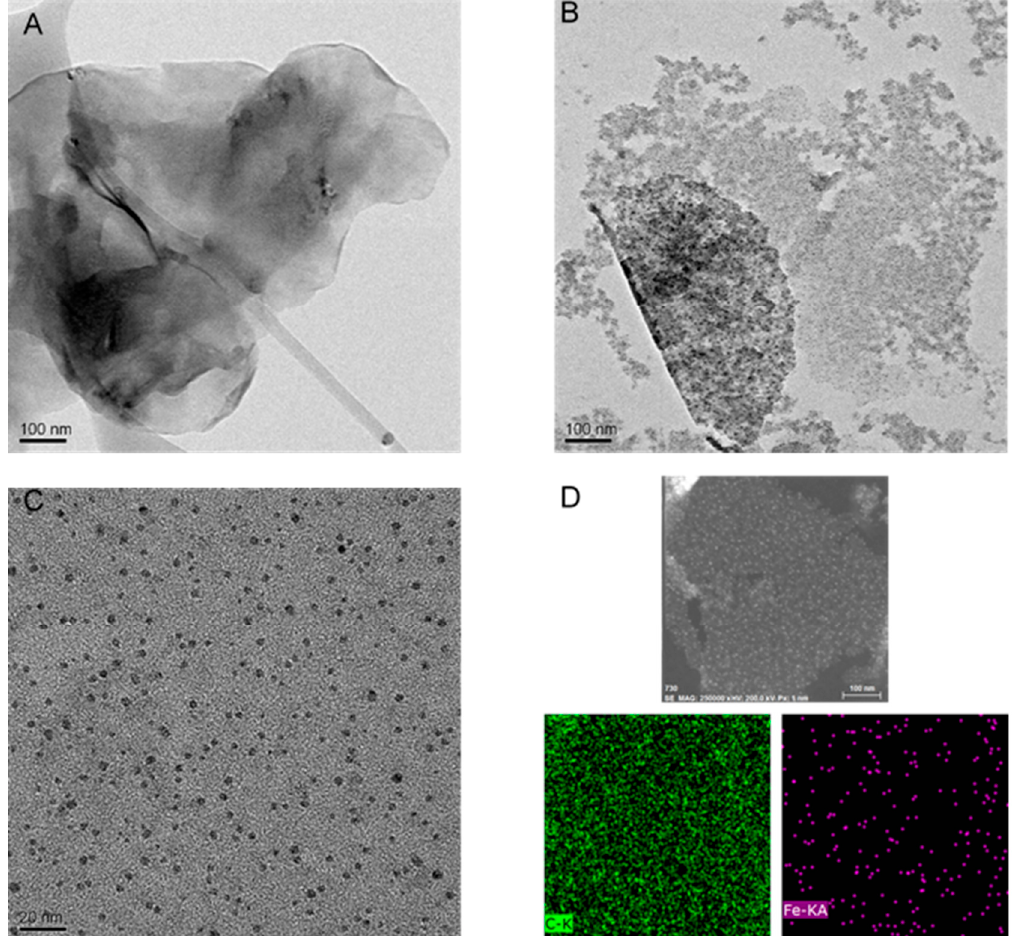
Figure 1. Transmission electron microscopic (TEM) images of GO ( A ) and m-rGO nano sheets ( B ). (C) TEM images of zoomed m-rGO with 5 nm diameter iron oxide nanoparticles (Scale bar, 20nm). ( D ) Energy-dispersive X-ray spectroscopy (EDS) element mapping of a portion of m-rGO.